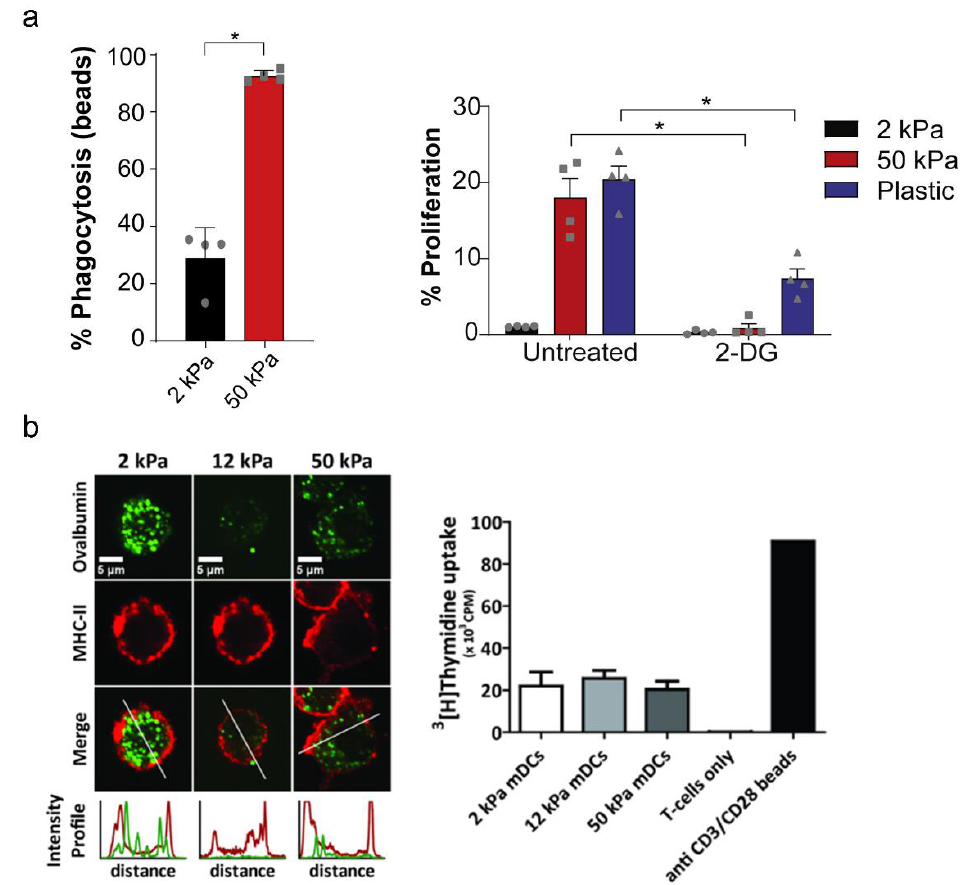
Figure 19. Mechanical stiffness controls DC immune functions, such as (a and b) phagocytosis and T cell proliferation. ( a ) BMDCs cultured on PDMS hydrogel with different stiffness. ( b ) Human peripheral blood monocyte- derived DCs cultured on PAM hydrogel with different stiffness in which gray dots, squares and triangles correspond to the different test values that BMDCs on 2 kPa, 50 kPa and plastic, respectively. (* p < 0.05, ** p < 0.01, *** p < 0.001 as determined by Mann-Whitney U test.) (reprinted/adapted with permission from Ref. [17], 2021, Chakraborty et al.; Reprinted/adapted with permission from Ref. [18], 2017, Mennens et